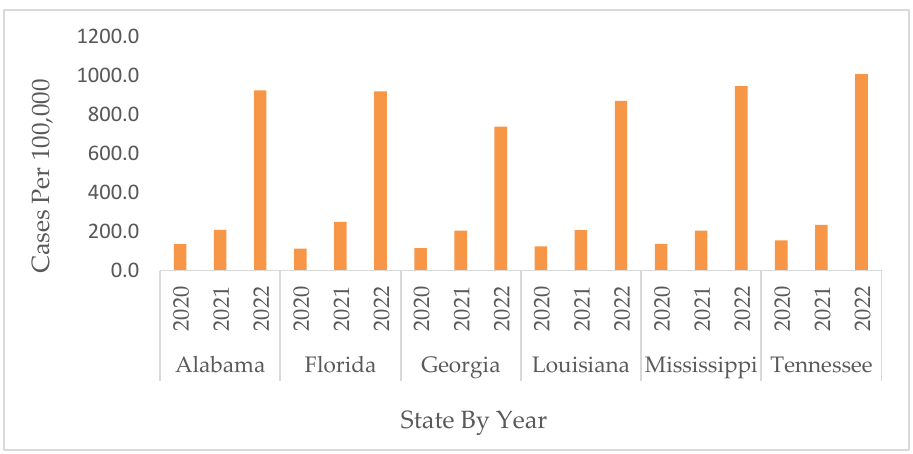
Figure 2. Average death rate by state from January 2020 through February 2022. The highest overall death rate was observed in AL.